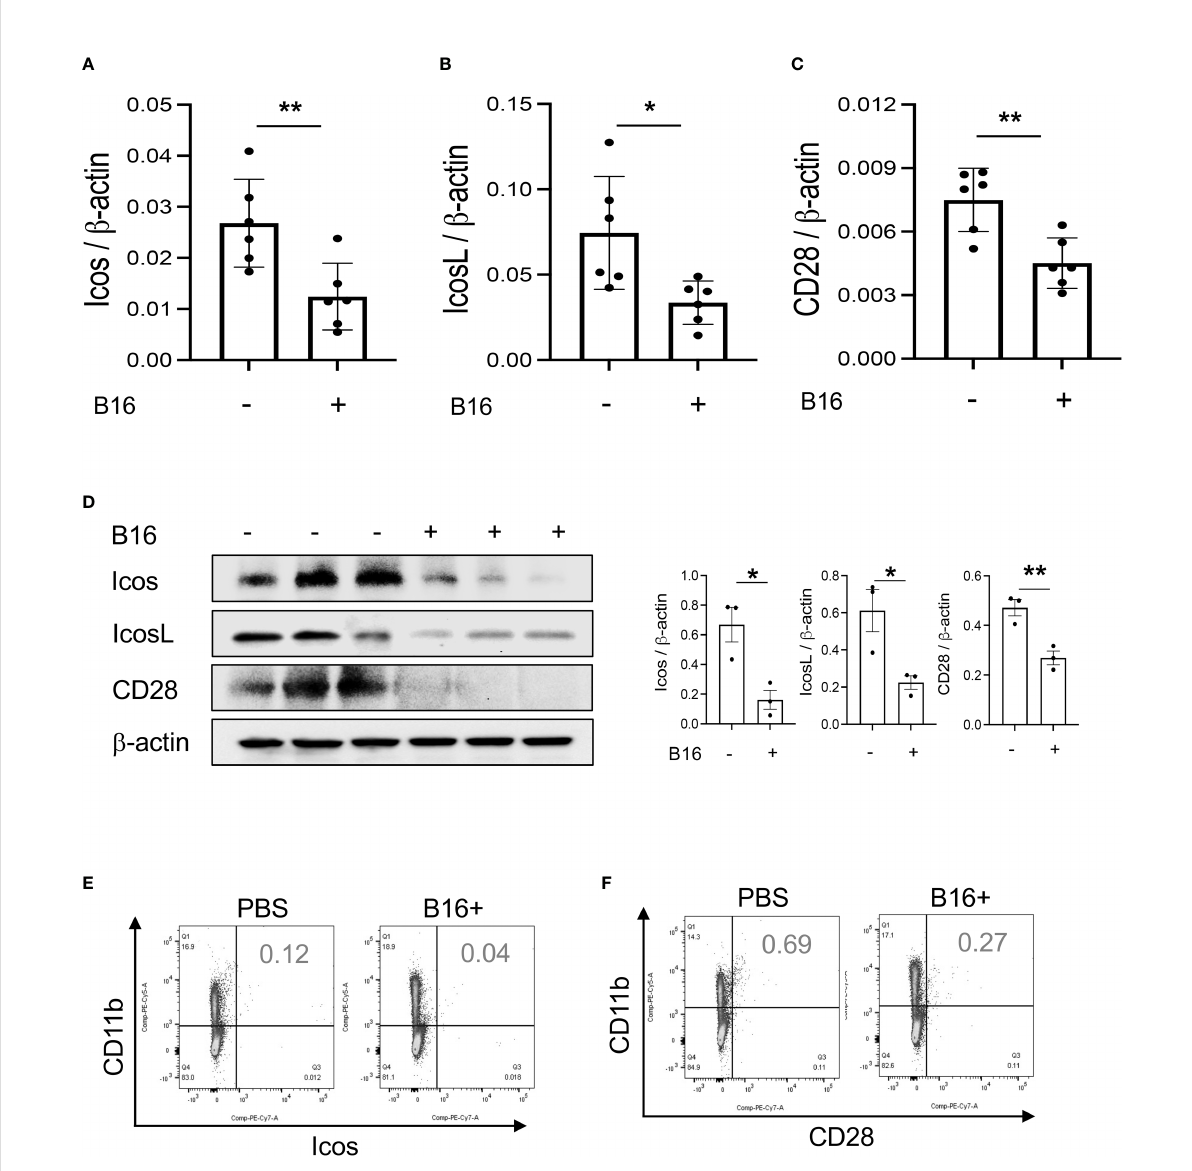
FIGURE 1 Pulmonary melanoma metastasis inhibits T cell co-stimulation. WT mice were given B16-F10 (B16) melanoma cells or control vehicle (PBS) and evaluated 2 weeks later. (A – C) Real-time RT-PCR (RT-PCR) was used to quantitate the levels of mRNA encoding ICOS, ICOSL and CD28 in the lungs from mice treated intravenously with PBS (B16 -) or B16 cells (B16 +). Each dot represents an evaluation in an individual animal. (D) Western blot and densitometry evaluations of ICOS, ICOSL and CD28 accumulation in lungs from mice treated with PBS (B16 -) or B16 cells (B16 +). (E, F) FACS evaluations quantitating the accumulation of ICOS and CD28 in cell populations from lungs of mice treated with B16 cells (B16+) or vehicle control (B16 -). These evaluations used speci fi c markers of airway myeloid cells. The values in panel A represent the mean ±SEM of the noted evaluations. Panels (D – F) are representative of a minimum of 2 similar evaluations. * P < 0.05, ** P < 0.01 ( t-